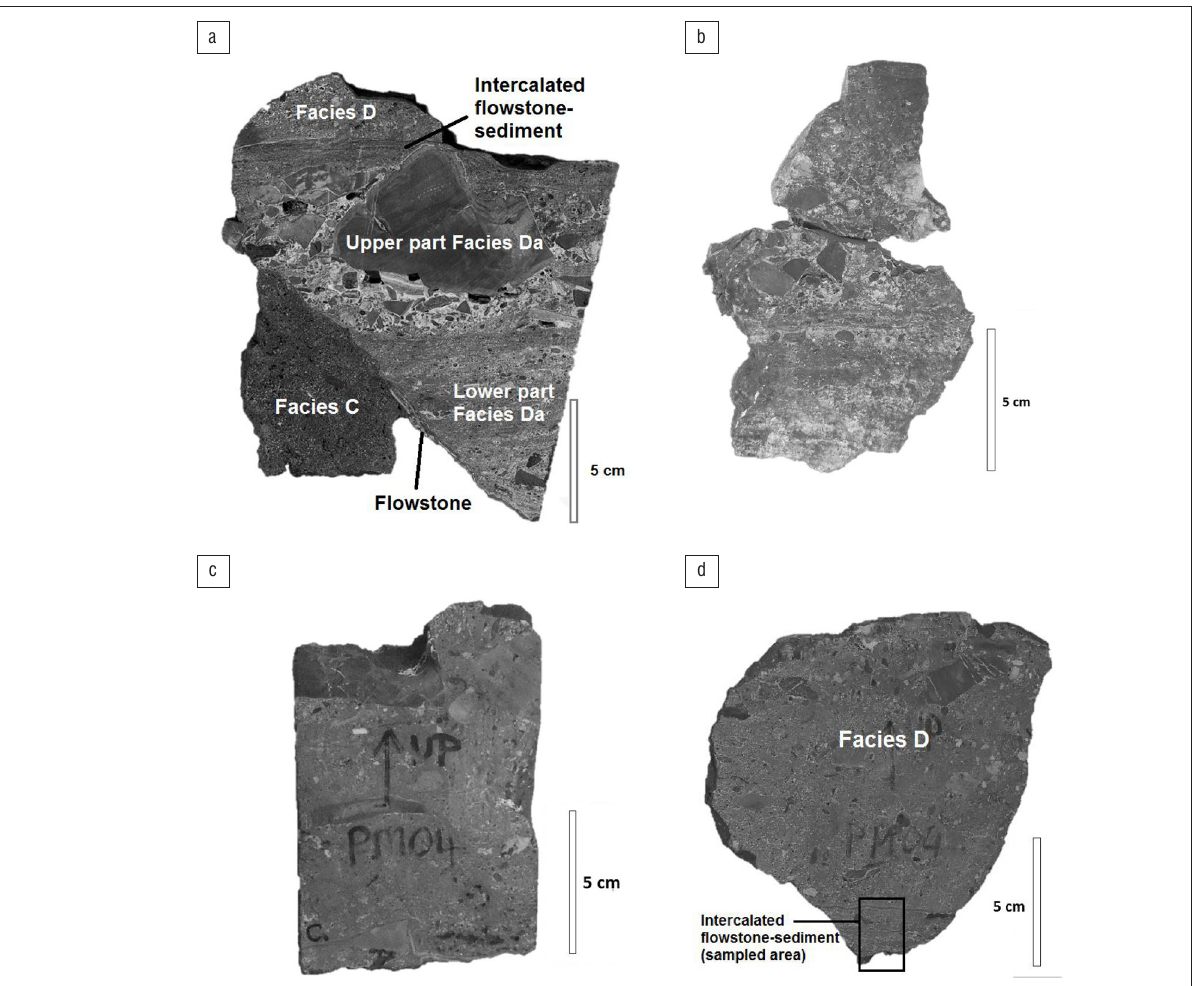
Figure 2: Malapa samples used in this study for carbonate stable isotope analysis: (a) UW88-PM09 (PM09), (b) PM09-2, (c) UW88-PM04 (PM04), (d) PM04-2. The PM09-2 is largely composed of Facies Da, whereas PM04 is largely Facies